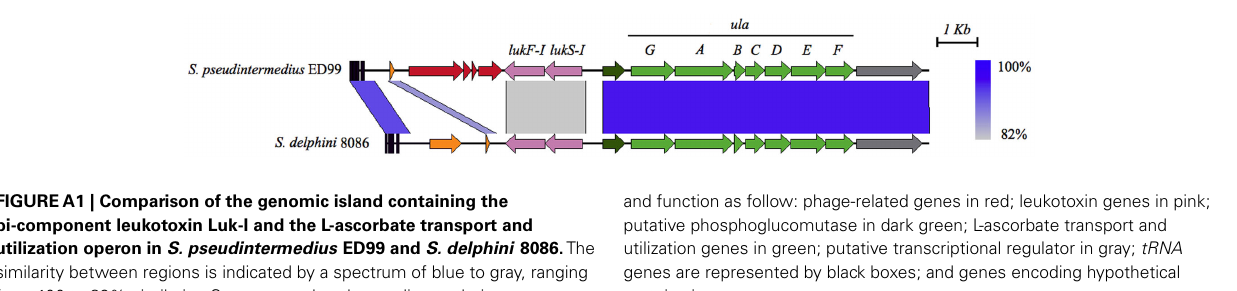
FIGUREA1 | Comparison of the genomic island containing the bi-component leukotoxin Luk-I and the L-ascorbate transport and utilization operon in S. pseudintermedius ED99 and S. delphini 8086. The similarity between regions is indicated by a spectrum of blue to gray, ranging from 100 to 82% similarity. Genes are colored according to their sequence